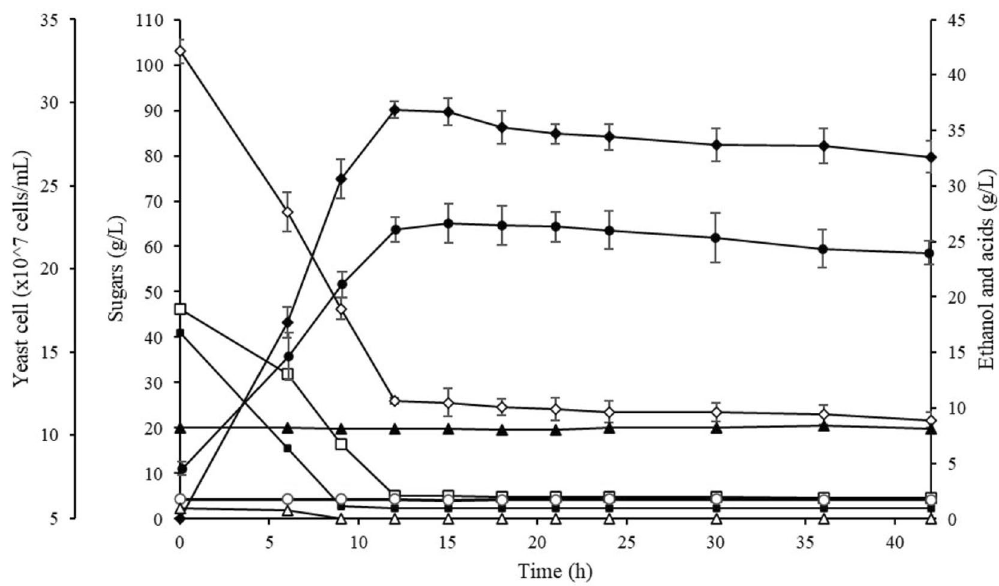
Figure 3. Time profile of ethanol production from pineapple waste hydrolysate using S. cerevisiae HG1.1 under optimum conditions. Symbols: filled black rhombus, ethanol; unfilled rhombus, total sugars; filled black square, glucose; unfilled square, fructose and xylose; unfilled circle, arabinose; unfilled triangle, formic acid; filled black triangle, acetic acid; filled black circle, yeast